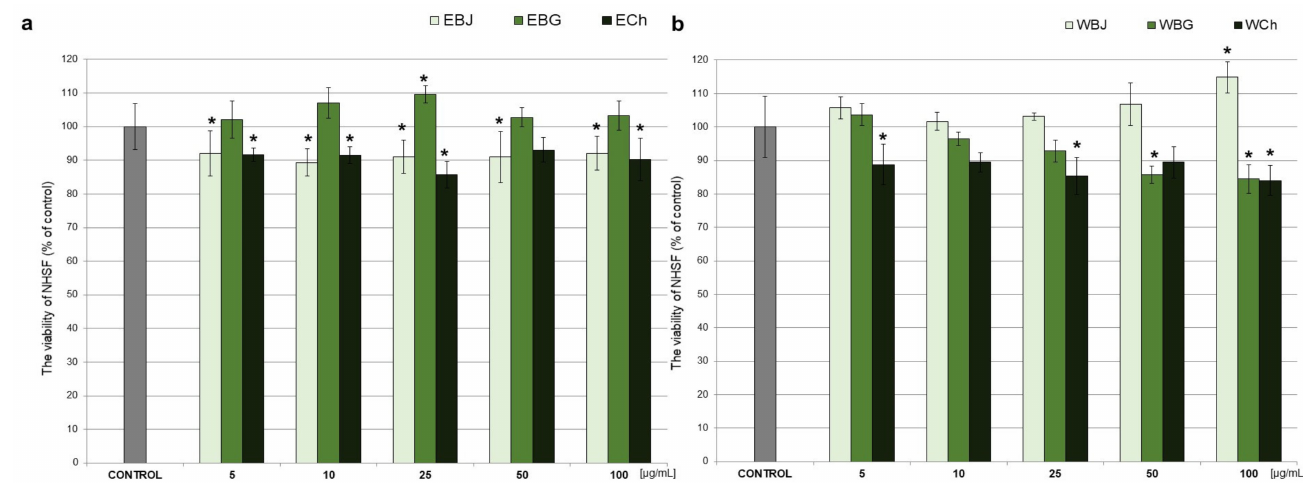
Figure 3. Effect of 70% ethanolic extract of young barley juice (EBJ), young barley grass (EBG) and chlorophyll (ECh) ( a ) and water extracts of young barley juice (WBJ), young barley grass (WBG) and chlorophyll (WCh) ( b ) at different concentrations (5, 10, 25, 50, 100 µ g/mL) on the viability of normal human skin fibroblasts (NHSF) after 48 h incubation. The results are presented as percentage of control. * p < 0.05—statistically significant difference from control. Statistically significant difference between particular doses of the tested extracts ( p < 0.05—EBG 5 vs. ECh 5, EBG 50 vs. ECh 50, EBJ 100 vs. EBG 100, WBG 10 vs. WCh 10, WBJ 50 vs. WCh 50, EBJ 10 vs. EBG 10, EBG 10 vs. ECh 10, EBJ 25 vs. EBG 25, WBJ 10 vs. WCh 10, WBJ 25 vs. WBG 25, WBJ 25 vs. WCh 25, WBJ 50 vs. WBG 50, EBG 25 vs. ECh 25, WBJ 100 vs. WBG 100, WBJ 100 vs. WCh